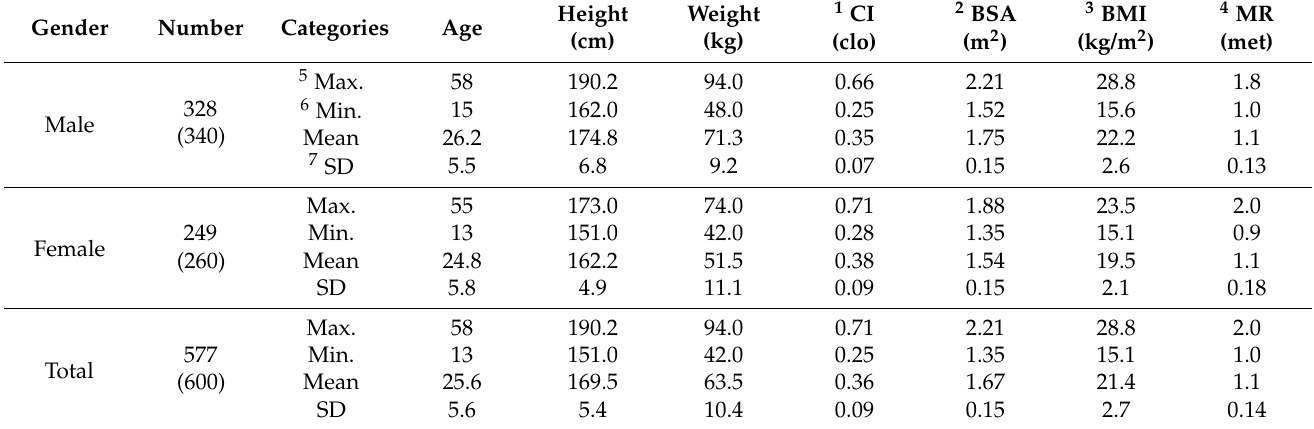
Table 3. Summary of background information of investigated subjects.